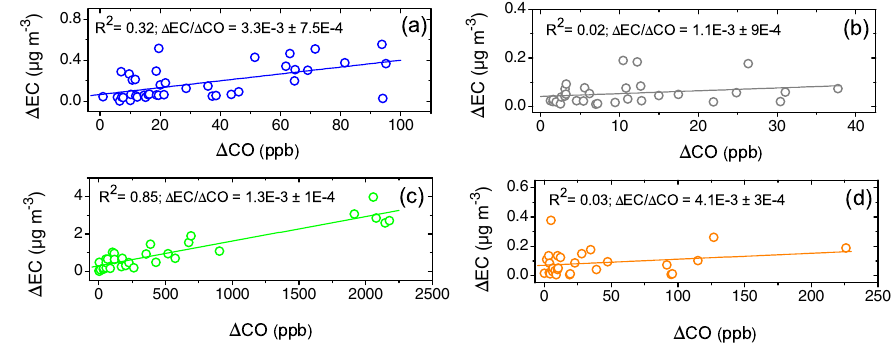
Figure 5. Seasonal relationship between (cid:49) EC and (cid:49) CO: winter (a) , spring (b) , summer (c) , and fall (d) during pollution periods, using all data obtained at ZOTTO from April 2010 to June 2014. The linear fit is shown for reference: R 2 – coefficient of determination; (cid:49) OC /(cid:49) EC slope ± 1SD in µgm − 3 ppb − 1 . The polluted (cid:49) EC and (cid:49) OC concentrations were calculated as the difference between measured and REBS- defined background